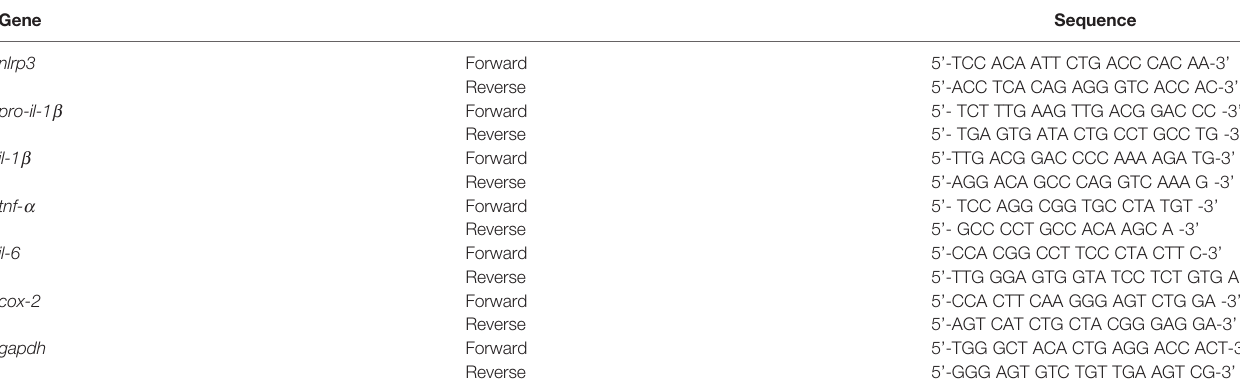
TABLE 2 | Sequences of primers used for real-time qPCR.